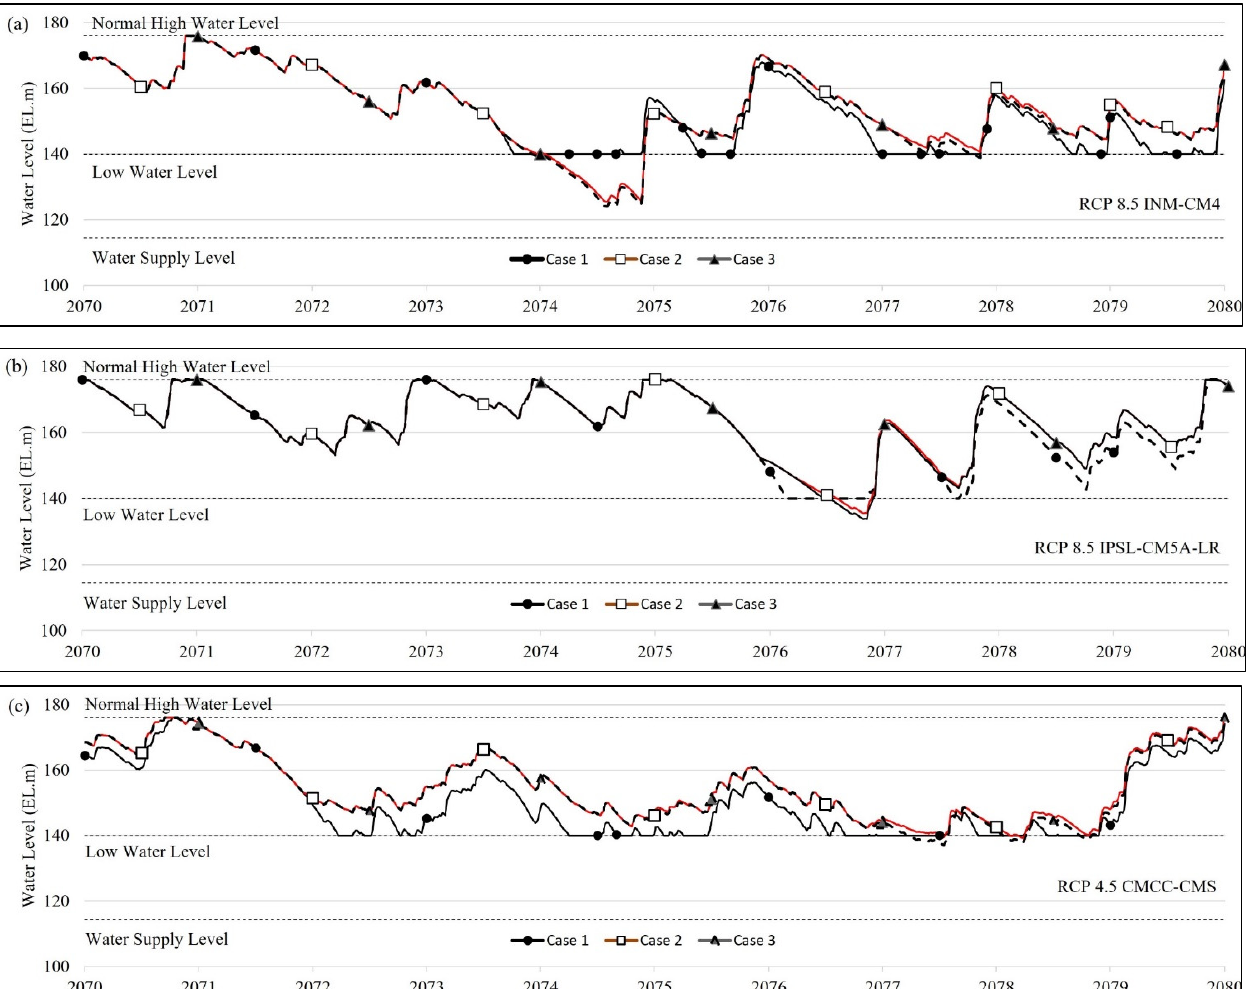
Figure 7. Changing water level in Hapcheon reservoir for Case 1, Case 2, and Case 3 in Scenario RCP 8.5 INM-CM4 ( a ), RCP 8.5 IPSL-CM5A-LR ( b ), and RCP 4.5 CMCC-CMS ( c ) from 2070 to